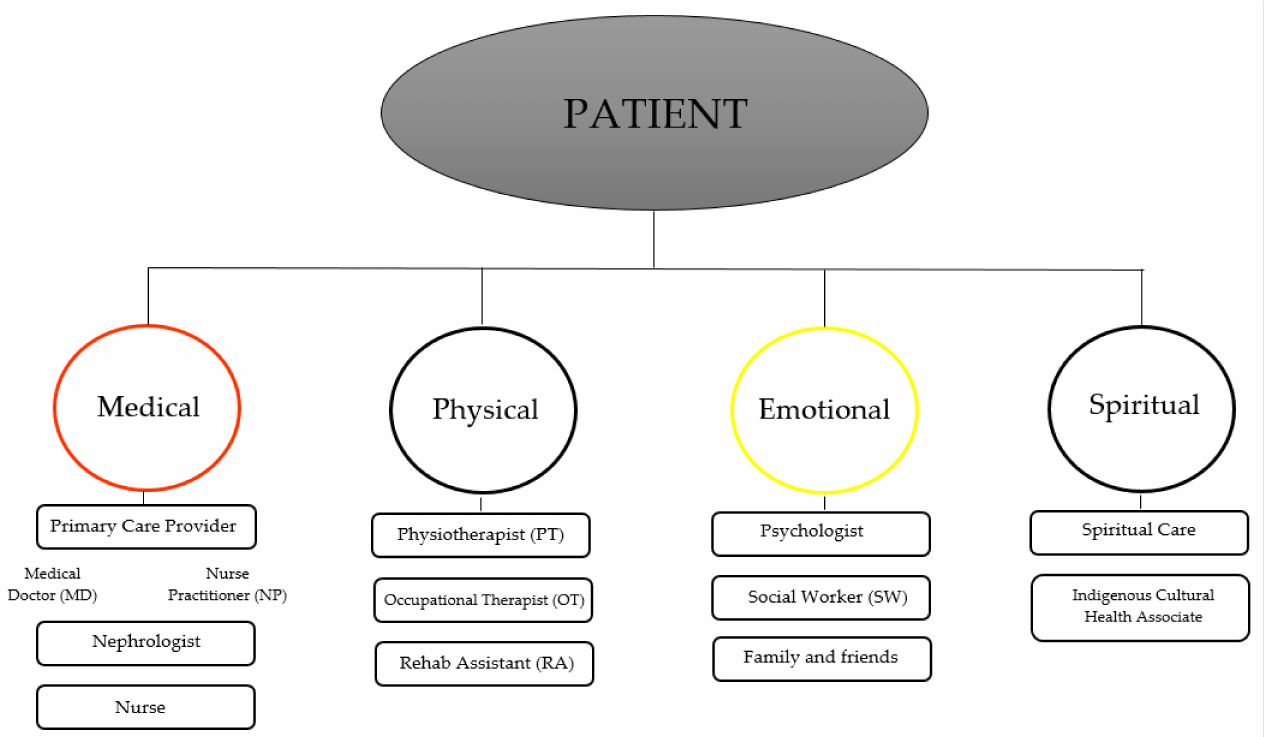
Figure 3. Illustrates the significance of a multidisciplinary team as it promotes a holistic approach to patient